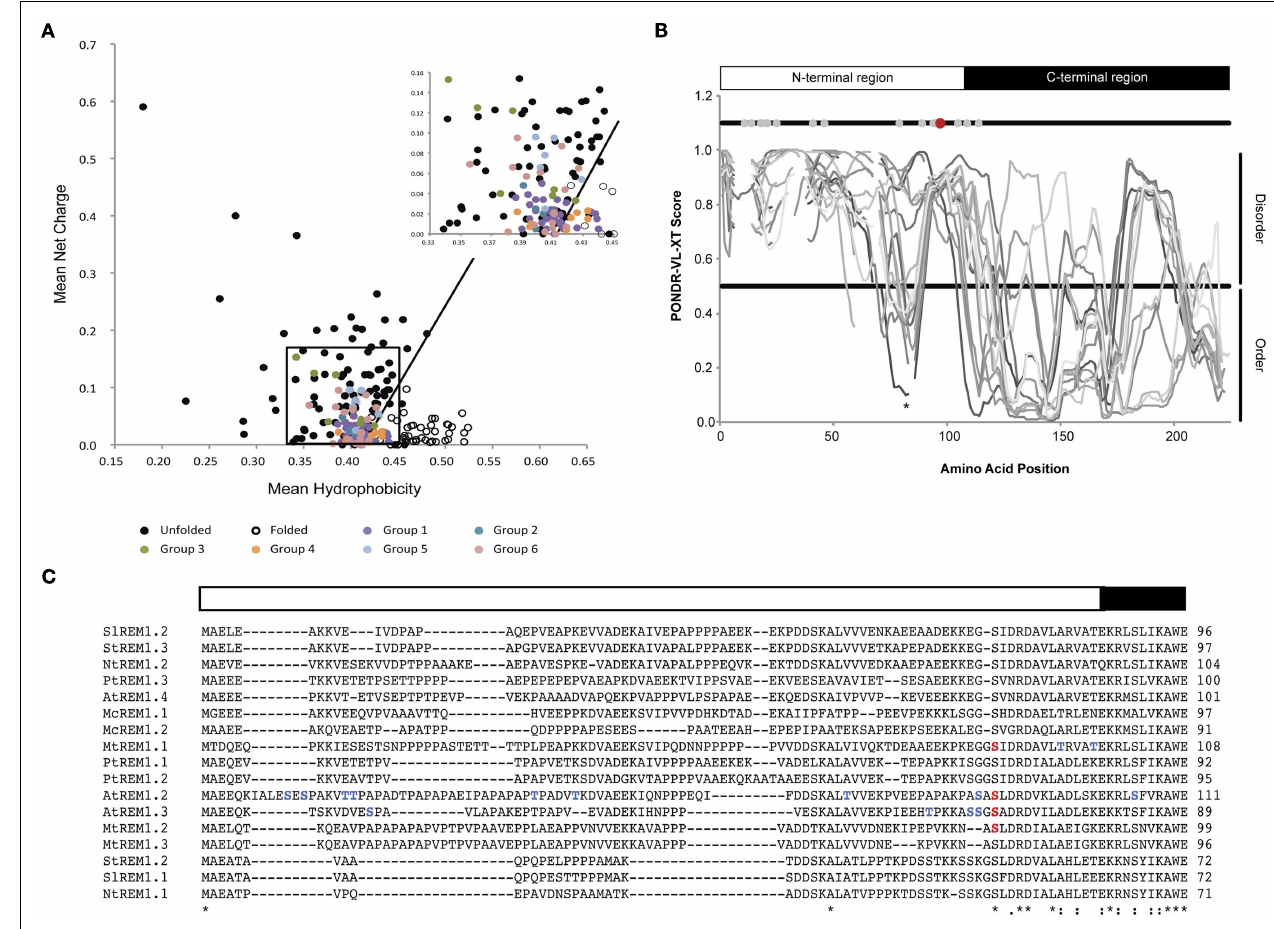
FIGURE 1 | Intrinsic disorder in remorin proteins. (A) Charge-hydrophobicity phase space for the remorin protein family. Black circles depict intrinsically disordered proteins described in the literature (data taken partially from Uversky et al., 2000).White circles depict natively folded proteins obtained from PDB database. Colored circles depict remorin proteins belonging to the six phylogenetic groups.The black box highlights zoomed region on the right corner.The solid black line represents border between intrinsically disorder proteins and folded proteins and is described by the formula: (cid:2) R (cid:3)= 2.785 (cid:2) H (cid:3) − 1.151, where (cid:2) R (cid:3) and (cid:2) H (cid:3) are the mean net charge and the mean net hydrophobicity, respectively. (B) Intrinsic disorder prediction of group 1b remorin proteins. Predictions were performed using the PONDR VL-XT program on a set of 17 group 1b remorins, which belong to Arabidopsis thaliana, Mesembryanthemum crystallinum, Medicago truncatula, Nicotiana tabaccum, Populus trichocarpa, Solanum lycopersicum , and Solanum tuberosum . Gaps in the plot represent gaps in the sequence alignment. Gray